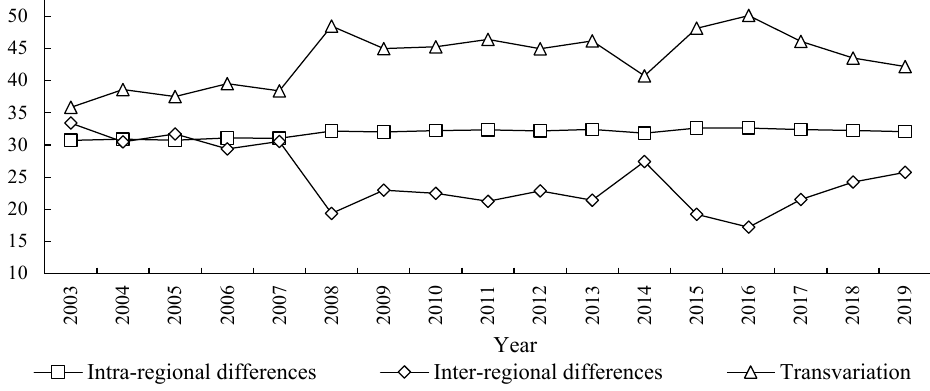
Figure 7. The contribution sources of regional differences and evolution trends of ECP in the YRB. From the time evolution trend, the contribution rate of intra-regional differences is relatively stable, showing a trend of “slightly rising-keeping stable”. At first, it slowly increased from 30.73% in 2003 to 32.16% in 2008, and then basically remained between 32% and 33%. The contribution rate showed a slight upward trend on the whole, the average increase rate is only 0.27% every year. Secondly, the contribution ratio in term of inter-regional differences showed a trend of continuous fluctuation, it dropped slightly from 33.41% in 2003 to 19.34% in 2008, then fluctuated to 27.42% in 2014, and dropped slightly to 17.21% in 2016. Finally, it rose slightly to 25.74% in 2019. The overall contribution ratio of inter-regional differences in 2003–2019 showed a slowly downward trend, with an av- erage decline rate of 1.1% every year. Thirdly, the contribution rate of the density of trans- variation also showed a trend of continuous fluctuation in . At first, it rose slightly from 35.87% in 2003 to 48.50% in 2008, then the fluctuation dropped to 40.74% in 2014, and it rose to 50.15% in 2016. Finally, it remained at 42.19% in 2019. The overall contribution ratio of the density of transvariation indicated an upward trend, the average increase ratio was 1.02% every year.